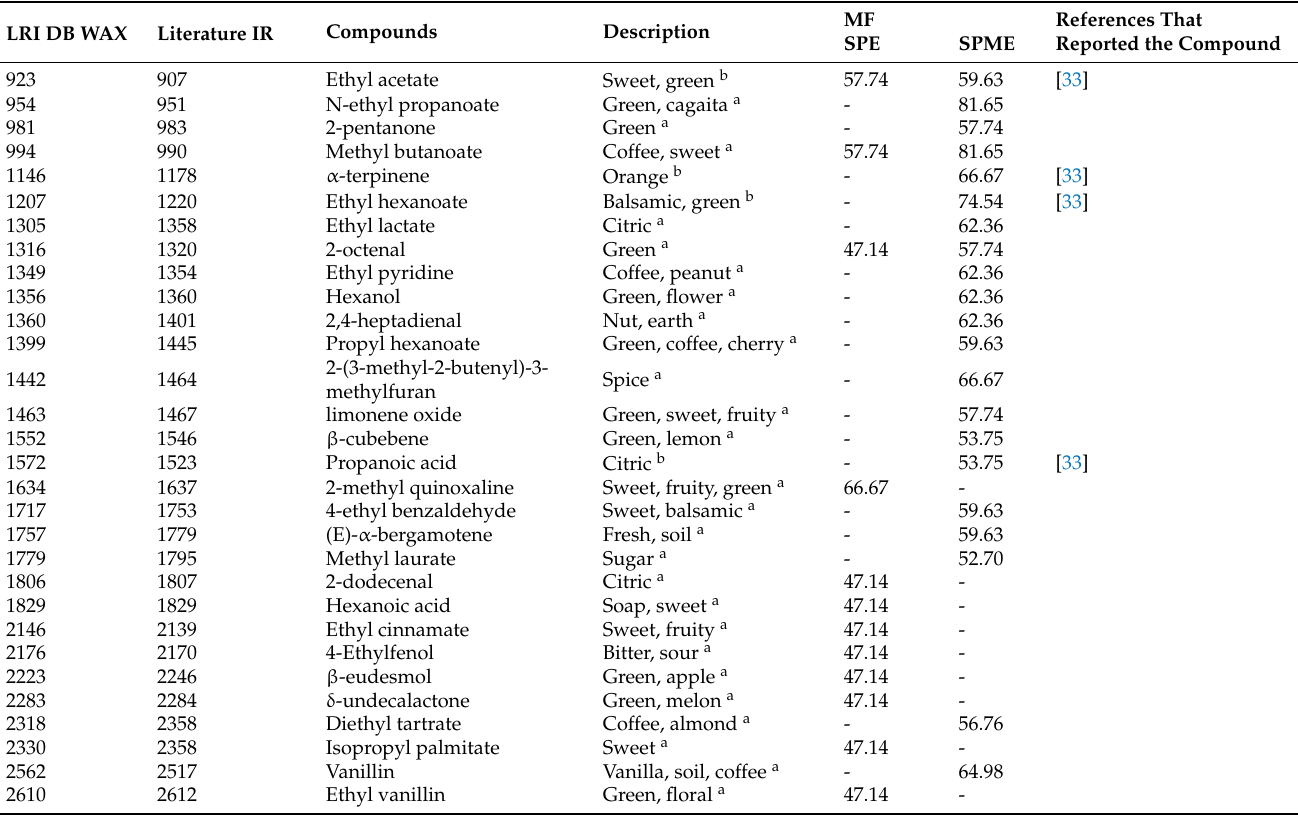
Table 3. Gas chromatography retention data, olfactometry description, chemical identification, and modified frequency (MF) (%) for odorants identified in cagaita pulp obtained using headspace solid-phase microextraction (HS-SPME) and headspace solid-phase extraction (HS-SPE) and gas chromatography-olfactometry